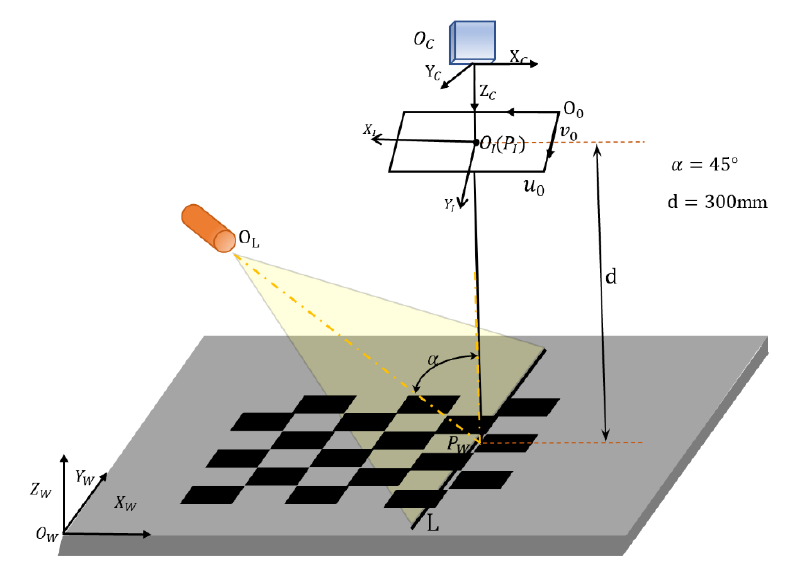
Figure 1. Measurement principle diagram of line structured light system.